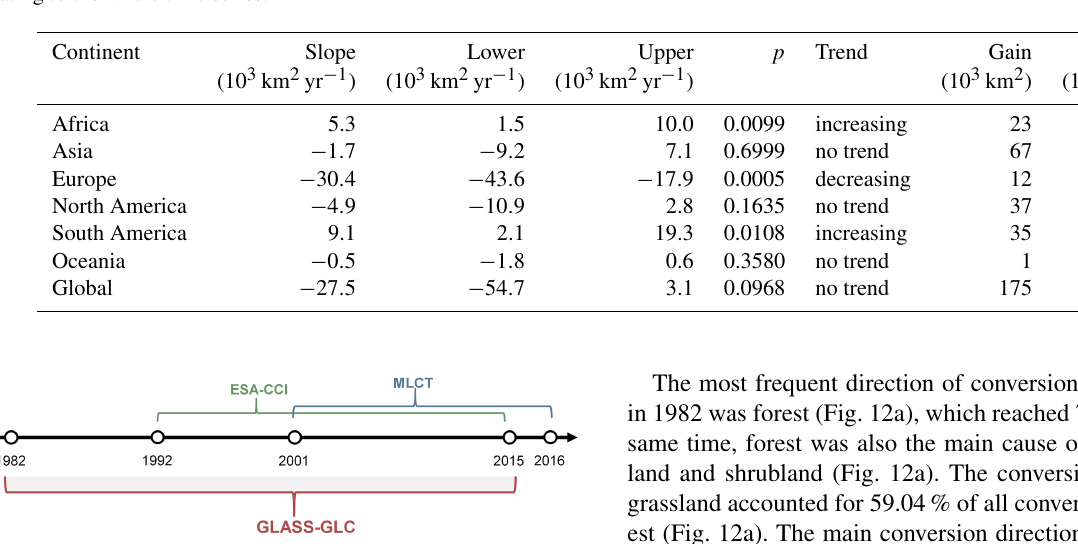
Figure 7. Intercomparison with the FAOSTAT data set: (a) cropland circa 2015, (b) forest circa 2015; (c) mean R 2 of the annual linear fit lines of cropland for years 1982–2015 and forest for years 1990–2015. Table 9. Statistical results of change analysis for cropland (on the scale of continents). Annual change slope and its 95% confidence interval are given by Theil–Sen estimator, p value, and trend information from a Mann–Kendall test. Gain and loss areas are summarized results relating to the whole time series.